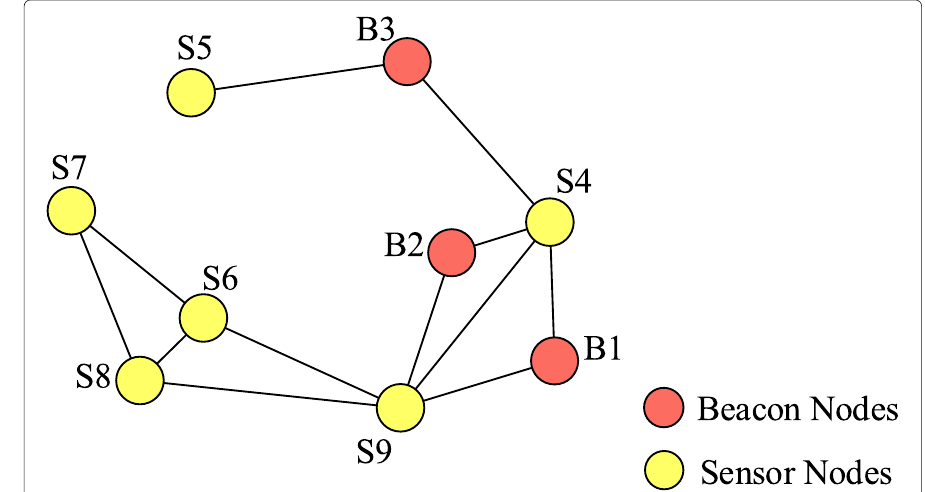
Fig. 3 The packet structure diagram corresponding to Table